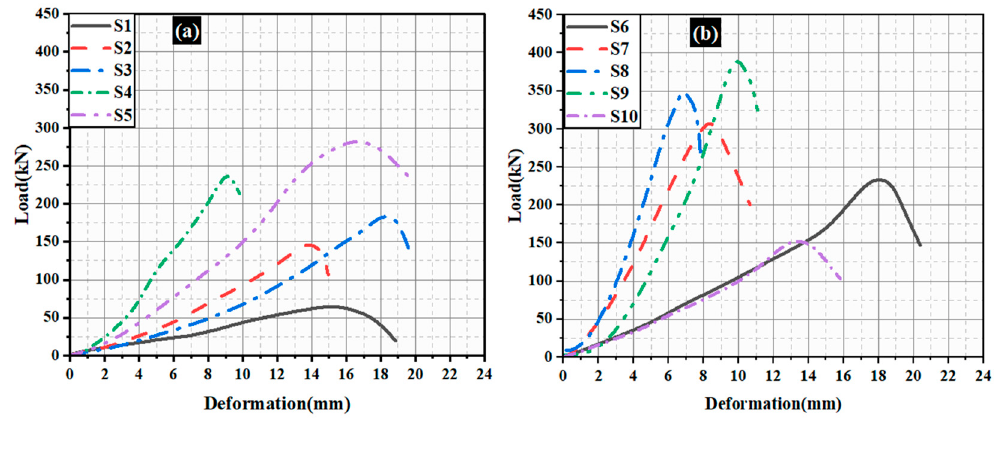
Figure 9. Load–axial-deformation behavior of ICF wall panels and masonry units.